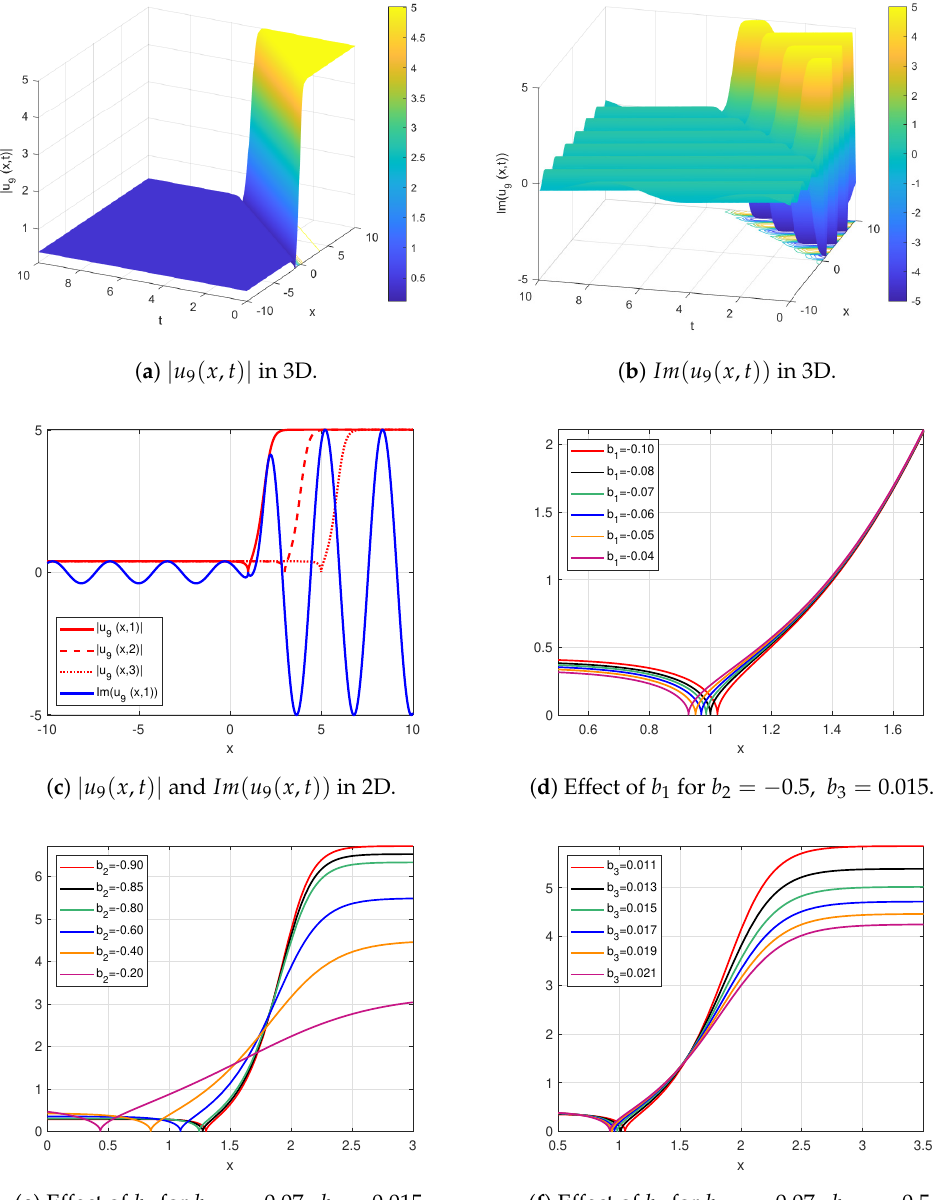
Figure 6. The various portraits of u 9 ( x , t ) in Equation (27) by combination of the Set 6 in Equation (17) and the selected h = 0.04, a = − 0.5, φ 0 = 0.5, b 1 = − 0.07, b 2 = − 0.5, b 3 = 0.015, κ = 2 values. Figure 7 is the graph obtained by the combination u 10 ( x , t ) in Equation (28), Set 7 in Equation (18) and the parameters h = 0.04, a = − 0.5, φ 0 = 0.5, b 1 = − 0.7, b 2 = 0.5, b 3 = 0.25, κ = 2, together. Figure 7a,c (red lines) are the 3D and 2D representations